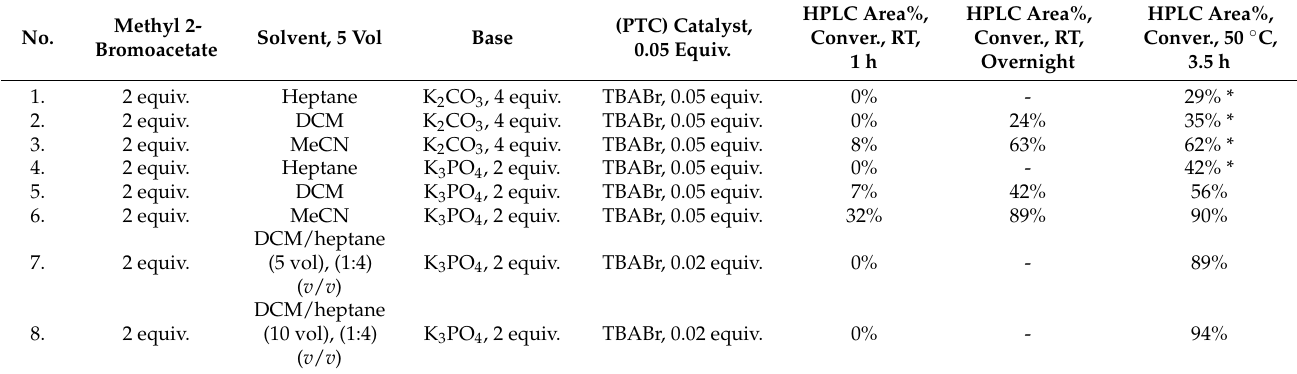
Table 3. Screen for suitable conditions for 2’-OH alkylation of 5-methyl cytidine